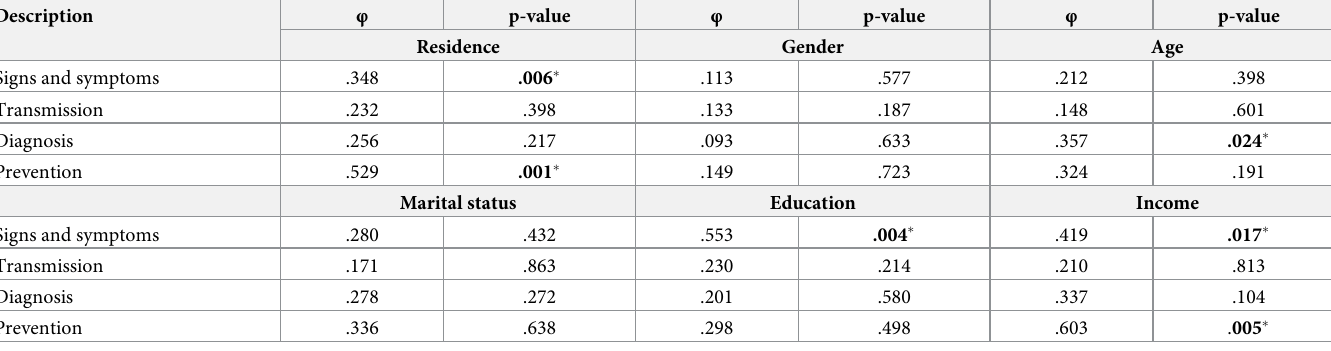
Table 3. Association between respondents’ socio-demographics and knowledge of